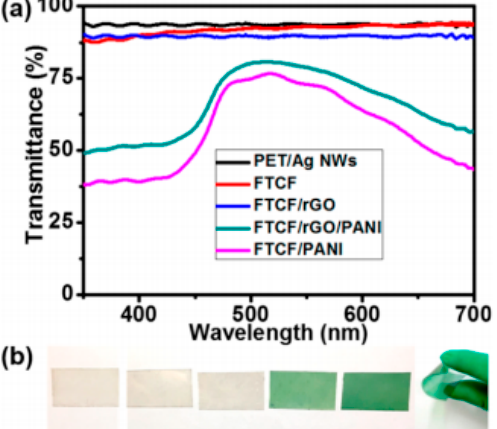
Figure 8. ( a ) Transparency spectra of PET/Ag NWs film, FTCF substrate, FTCF/rGO, FTCF/rGO/PANI and FTCF/PANI, respectively. ( b ) The photographs of corresponding film from (left to right) for PET/Ag NWs film, FTCF substrate, FTCF/rGO, FTCF/rGO/PANI, FTCF/PANI and the flexible FTCF/rGO/PANI [79]. Copyright 2017, American Chemical Society